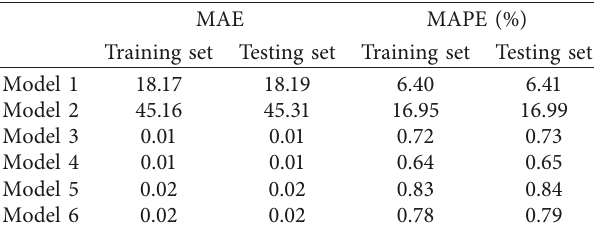
Table 9: MAE and MAPE of the